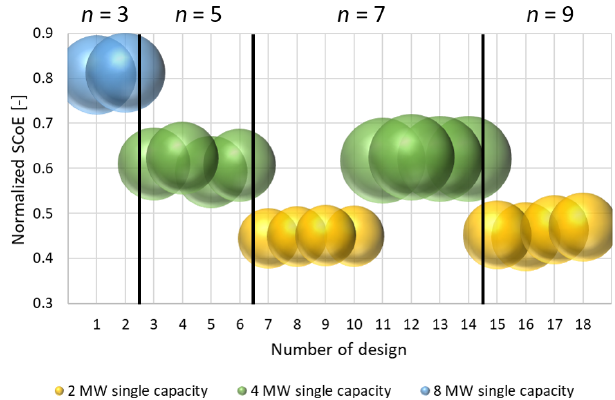
Figure 5. Normalized SCoE of the optimized SD-MRS designs.